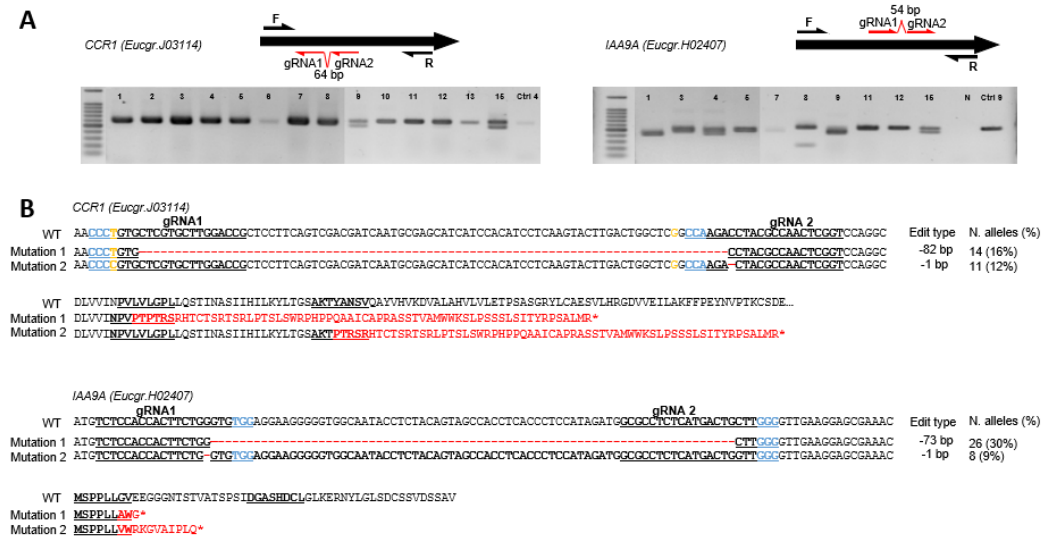
Figure 1. Genotyping of CCR1 and IAA9A transformants and their corresponding prevalent edition types. ( A ) Electrophoresis gels showing PCR amplicons for CCR1 (left panel) and IAA9A (right panel) transformants; the positions of the guide RNAs and of the primers used for PCR are indicated on the schematized ORF (open reading frame) sequences of the genes. The symbols above each lane indicate the transformant lines. In the panel of CCR1 transformants: 1 for CCR1_1 , 2 for CCR1_2 and so on; Ctrl-4, control line 4 . In the panel of IAA9A transformants: 1 for IAA9A_1 , 2 for IAA9A_2 and so on; N, PCR negative control. ( B ) Prevalent mutation types in alleles from transformants CCR1 and IAA9A , respectively. The top alignments show mutations in DNA sequences compared to the WT sequence (red dashes indicate deleted base pairs) and the consequences on the protein sequences are displayed below (altered amino acid sequences are in red). The sequences of sgRNA1 and sgRNA2 are underlined, Protospacer Adjacent Motif (PAM) sequences are indicated in blue. Two SNP positions in CCR1 are indicated in yellow. The mutation types, number of altered alleles detected and their corresponding occurrence in percentage in brackets are indicated on the right part of the figure. Majority of altered alleles introduced significant modifications at the protein level.